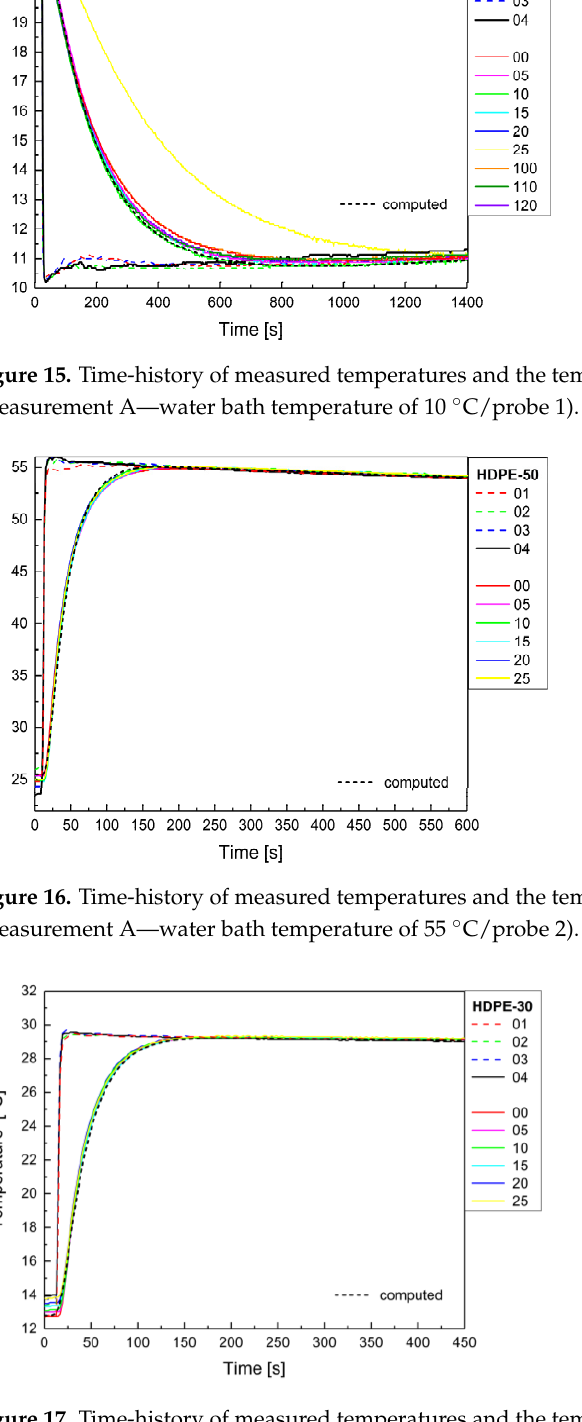
Figure 17. Time-history of measured temperatures and the temperatures computed in the probe axis (measurement A — water bath temperature of 30 °C/probe 2).